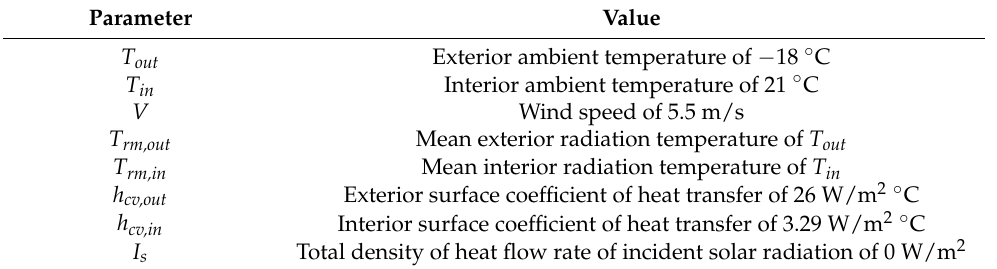
Table 2. NFRC simulation condition.